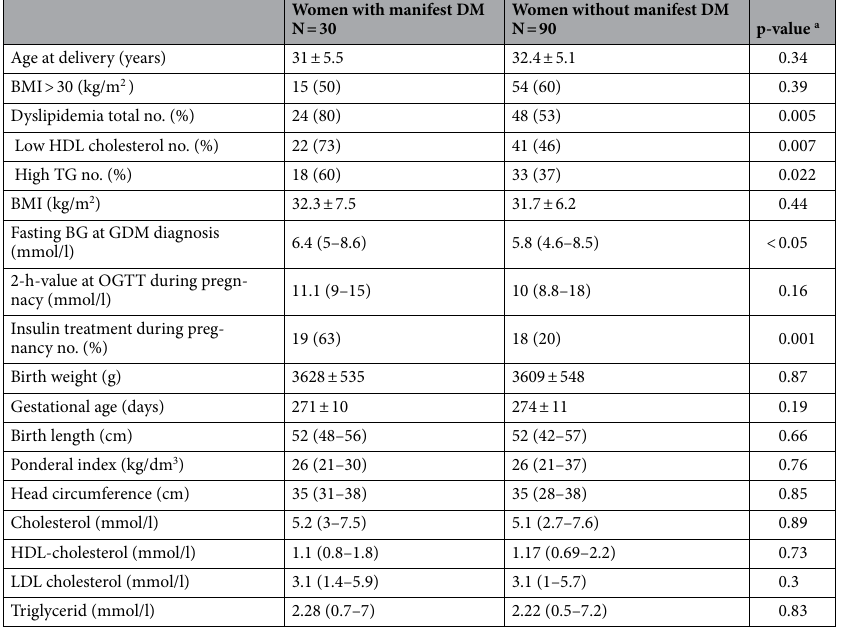
Table 2. Components of the diagnosis metabolic syndrome in 120 women with previous gestational diabetes by subsequent manifest diabetes diagnosis. Data are given as mean ± SD/median (range) or no. (% of column). DM Diabetes mellitus, BG Blood glucose. a Women with vs. without